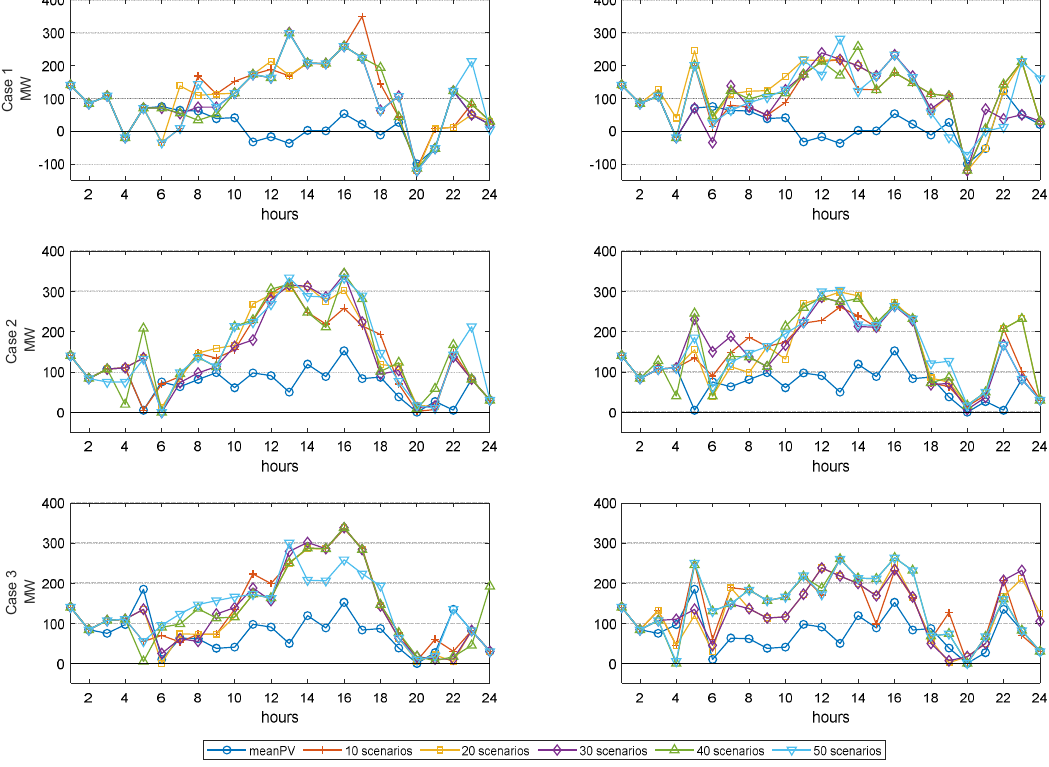
Figure 6. Di ff erence between the feasible reserve schedule and minimum reserve from the results considering PV scenarios (left column) and PV load scenarios (right column) for cases 1, 2, and 3 (top to bottom).